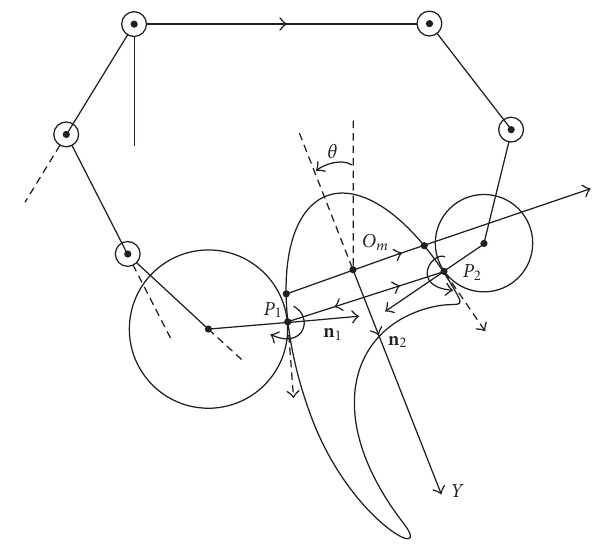
Figure 9: The pressing force to the object at P 1 in the direction n 1 induces a rotational moment around P 2 and vice